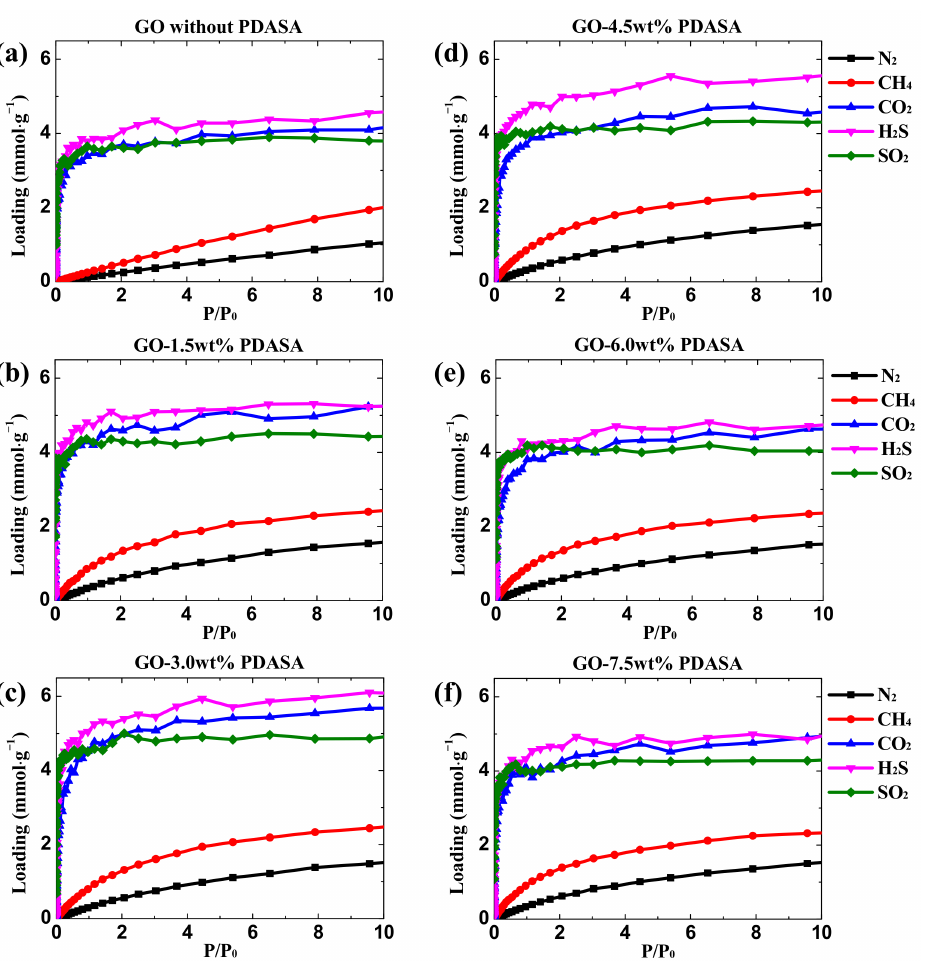
Figure 2. Unary isotherms of different gases in GO membranes with variable doping amounts of PDASA. ( a ) 0.0 wt%. ( b ) 1.5 wt%. ( c ) 3.0 wt%; ( d ) 4.5 wt%; ( e ) 6.0 wt%; ( f ) 7.5